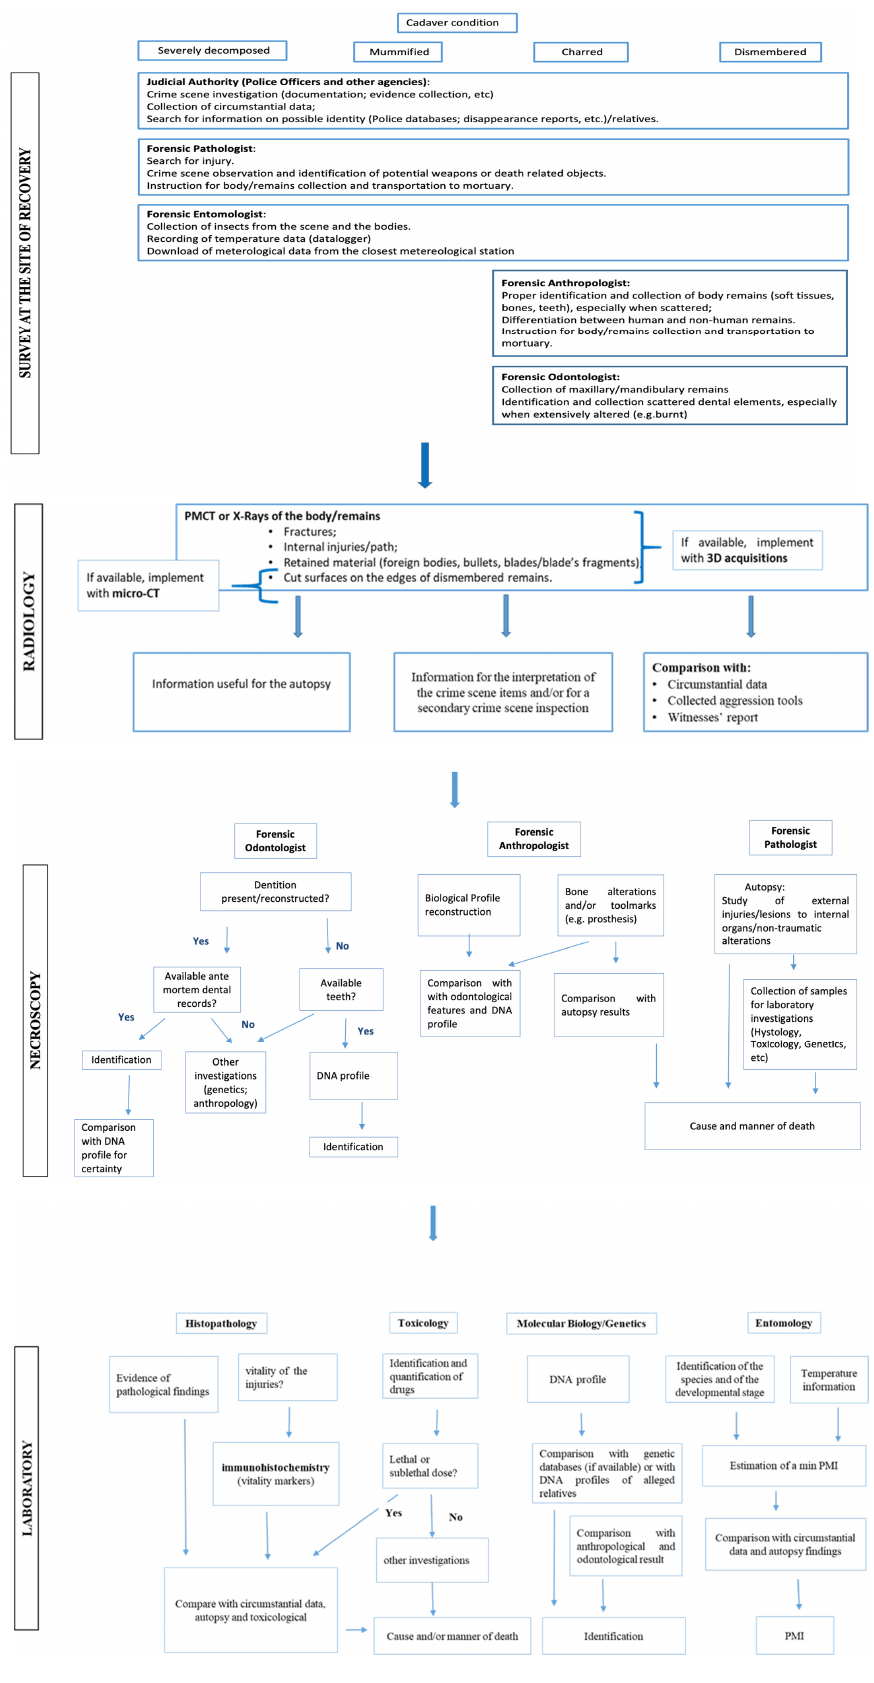
Figure 2. Procedural flowchart